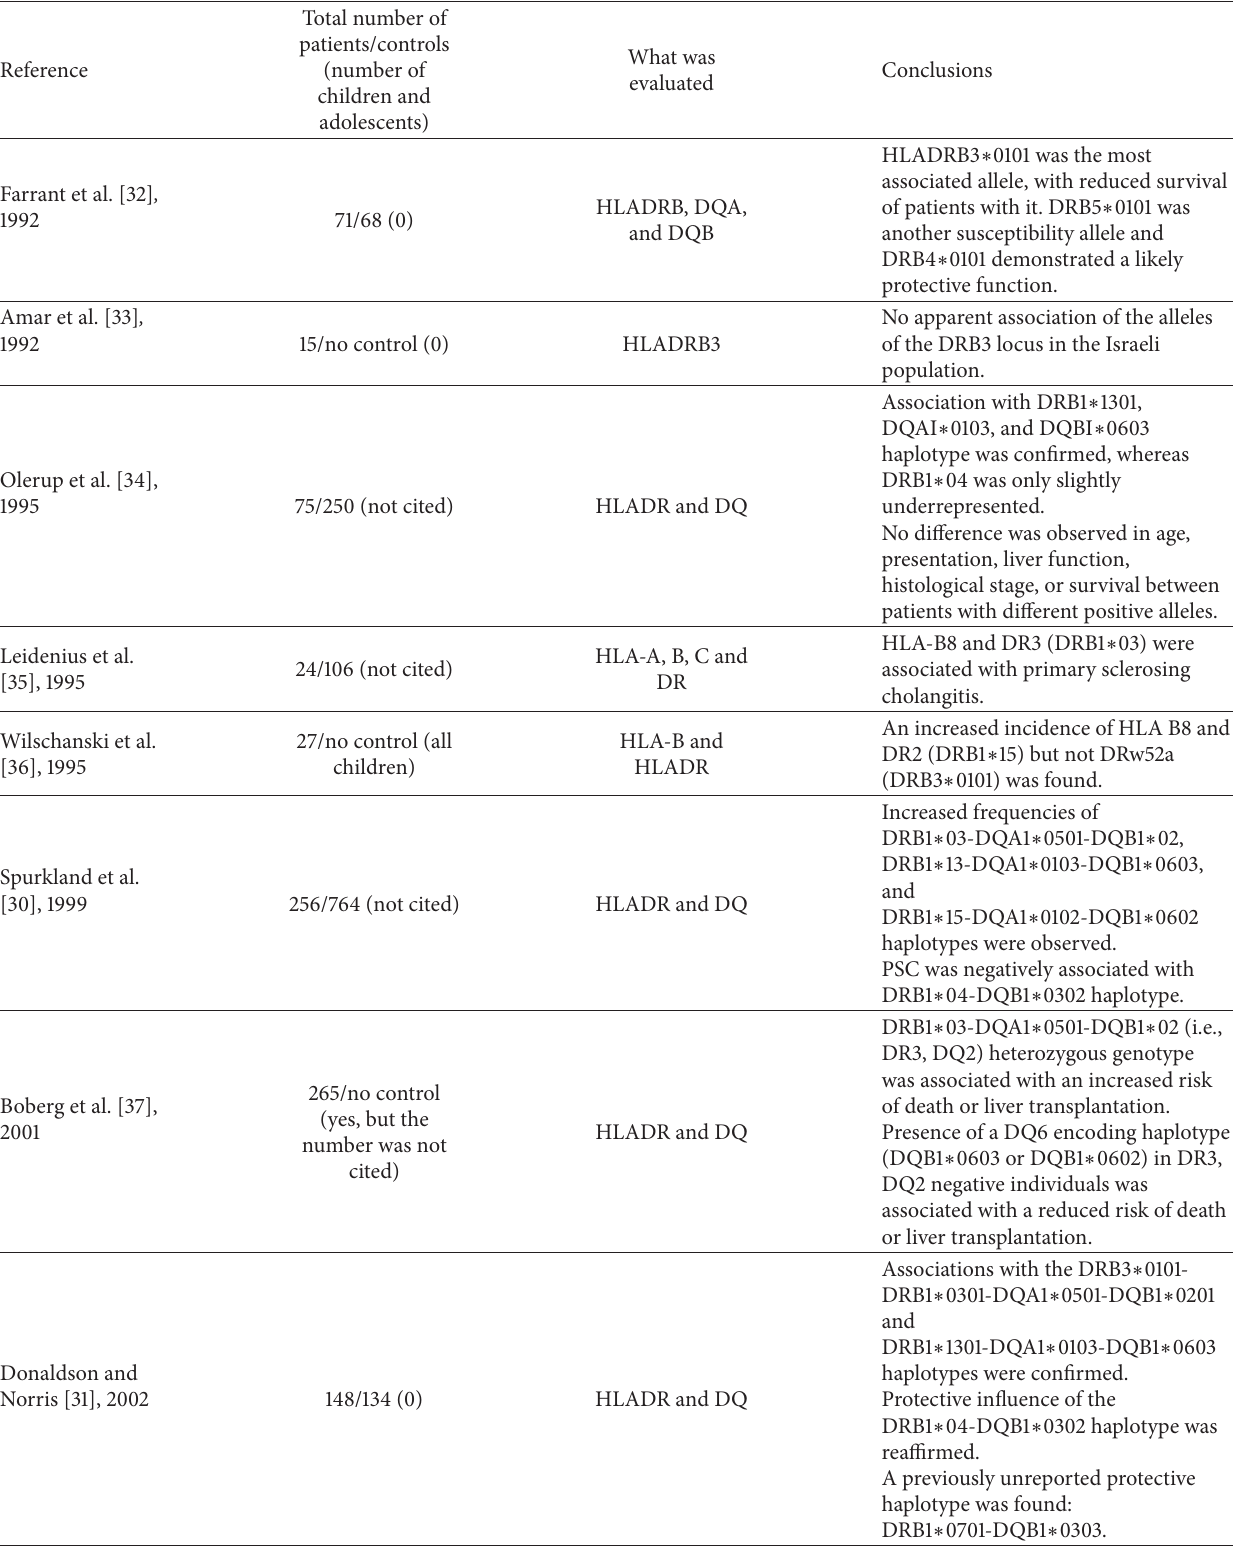
Table 1: Publications on major histocompatibility class II human leukocyte antigens and their association with primary sclerosing cholangitis